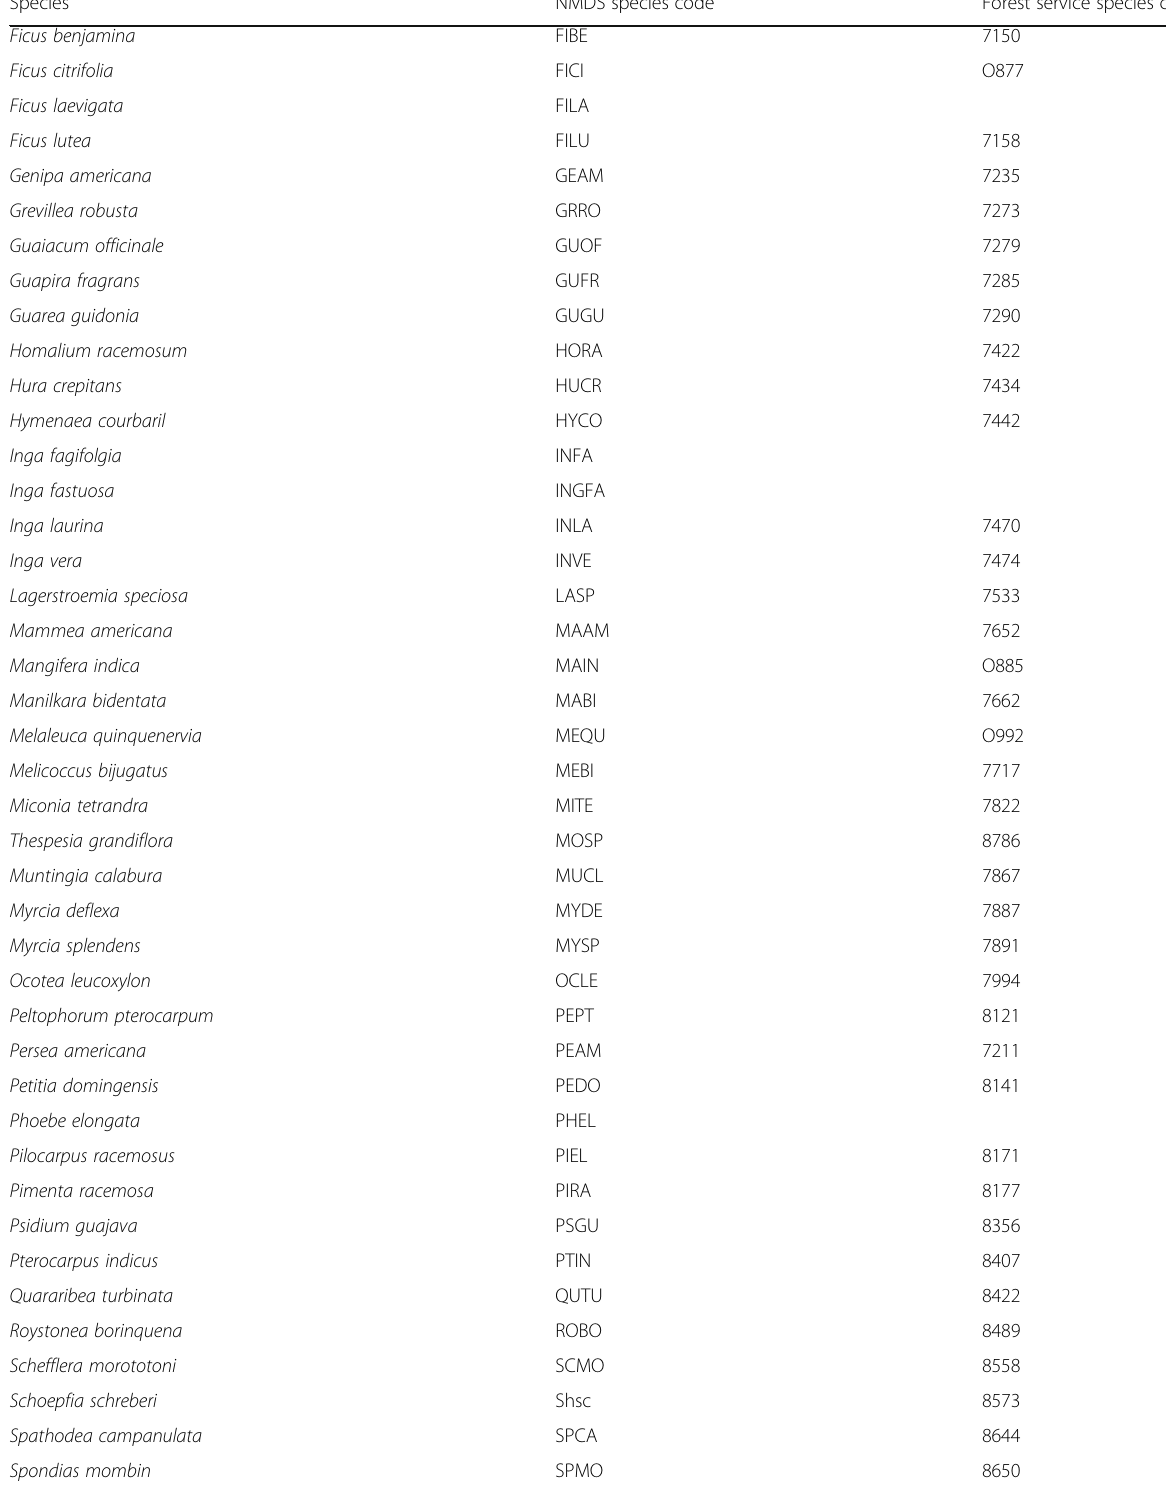
Table 7 Species found in JB-BN with species codes used in the Appendix 1 NMDS ordinations and found in Appendix G of the For- est Inventory and Analysis (FIA) user guide